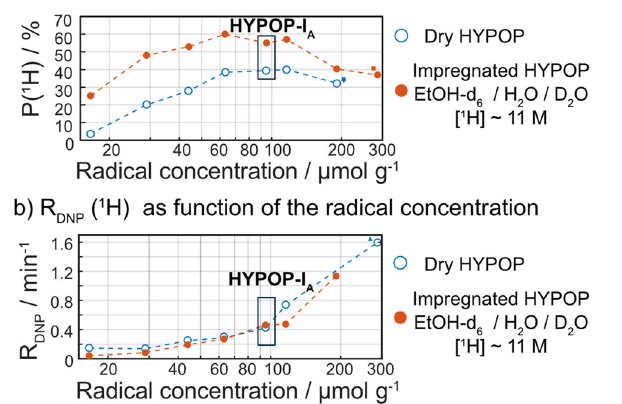
Fig. 3 1 H DNP performances of the HYPOP-I series. Samples were compared before (blue open circles) and after (red fi lled circles) impregnation with a solution of ethanol-d 6 /H 2 O/D 2 O (1/1/8 v/v/v), polarized at 1.4 K and 7.05 T, with a microwave frequency of f uw = 197.648 GHz using a triangular frequency modulation of width Δ f uw = 160 MHz and a modulation rate f mod = 500 Hz. a Steady-state 1 H polarization levels